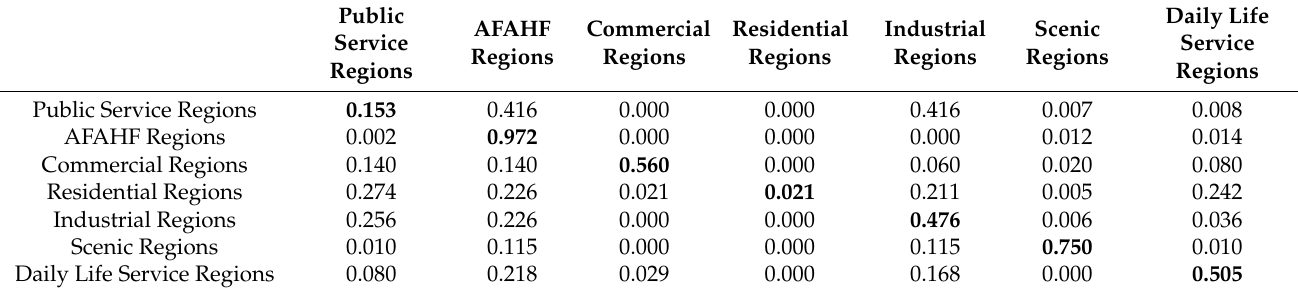
Table 6. Confusion matrix of identification result based on word2vec.